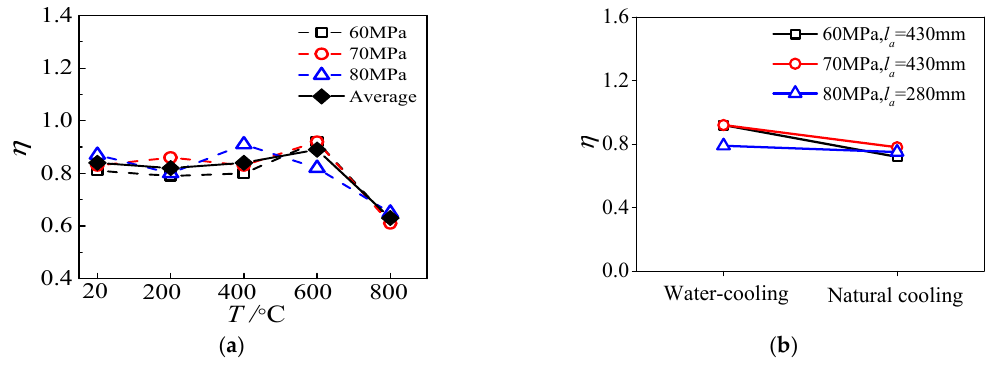
Figure 21. Energy dissipation area model.